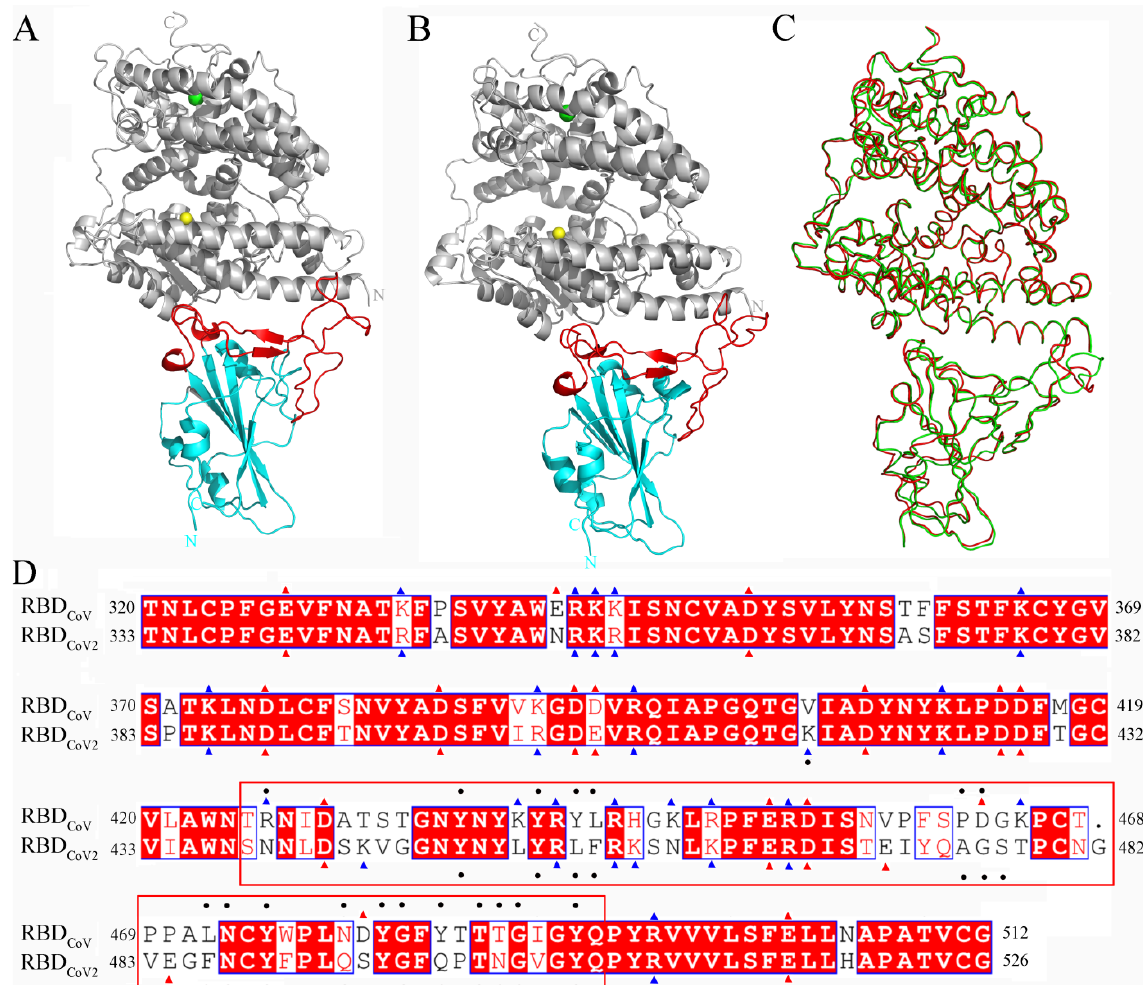
Figure 1 . Structures of the RBD CoV -ACE2 and RBD CoV2 -ACE2 complexes and sequence alignment of RBD CoV and RBD CoV2 . (A and B) Cartoon representations of the complete complex structures of RBD CoV -ACE2 (modeled based on the crystal structure with PDB ID 2AJF [13] ) and RBD CoV2 -ACE2 (PDB ID: 6M0J [14] ), respectively. ACE2 is colored gray, with Zn 2+ and Cl − ions represented as spheres in yellow and green, respectively; cores and RBMs of both RBDs are colored cyan and red, respectively. (C) Backbone superposition of RBD CoV -ACE2 (red) and RBD CoV2 - ACE2 (green). (D) Structure-based sequence alignment of RBD CoV and RBD CoV2 . The identical residues are white on a red background and the similar residues are red on a white background; the negatively and positively charged residues are indicated by red and blue triangles, respectively. The ACE2-contacting residues (or RBD interface residues) identified in this work are indicated by black dots; RBM (residues 438-506 according to residue number- ing of RBD CoV2 ) is highlighted by enclosure with a red box.